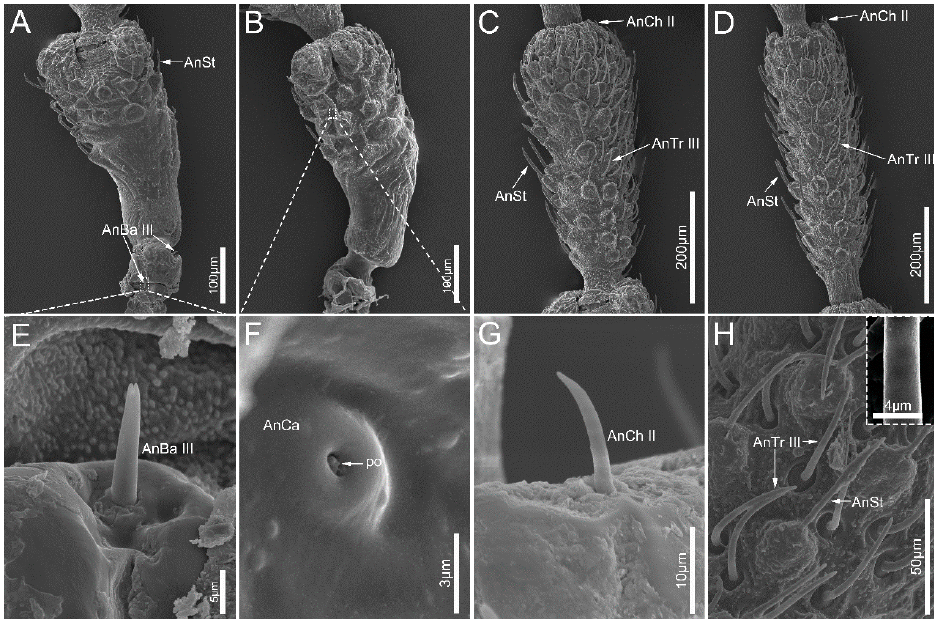
Figure 2. Scape, pedicel, and the first segment of flagellum of Mezira yunnana . ( A ) View of scape showing the localization of AnBa III; ( B ) view of scape showing the localization of AnCa; ( C ) lateral view of pedicel; ( D ) lateral view of the first segment of flagellum; ( E ) AnBa III on scape; ( F ) AnCa on pedicel; ( G ) AnCh II on the first segment of flagellum; ( H ) AnSt and AnTr III on the first segment of flagellum, with porous wall of antr III shown in the box; AnBa III, antennal sensilla basiconica III; AnCh II, antennal sensilla chaetica II; AnCh III, antennal sensilla chaetica III; AnCa, antennal sensilla campaniformia; AnSt, antennal sensilla styloconica; AnTr III, antennal sensilla trichodea III; po, pore. Table 1. Measurements of Mezira yunnana (mean ± SE).